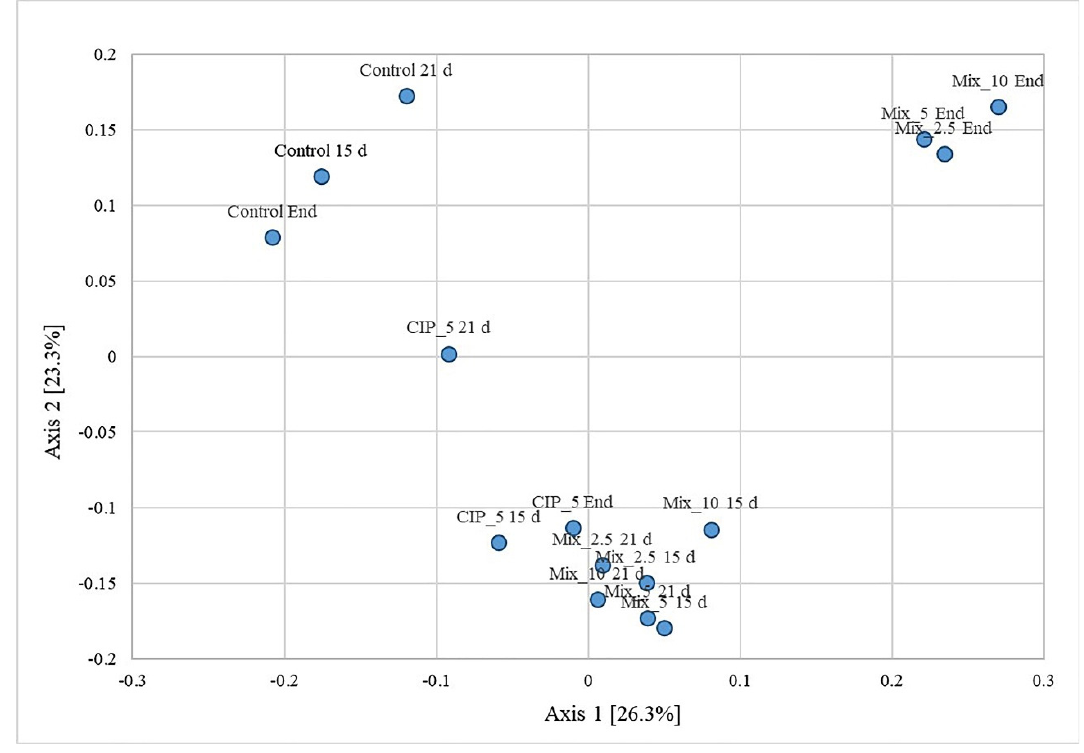
Figure 6. Principal Coordinate Analysis based on Bray–Curtis. The end-time is day 69.